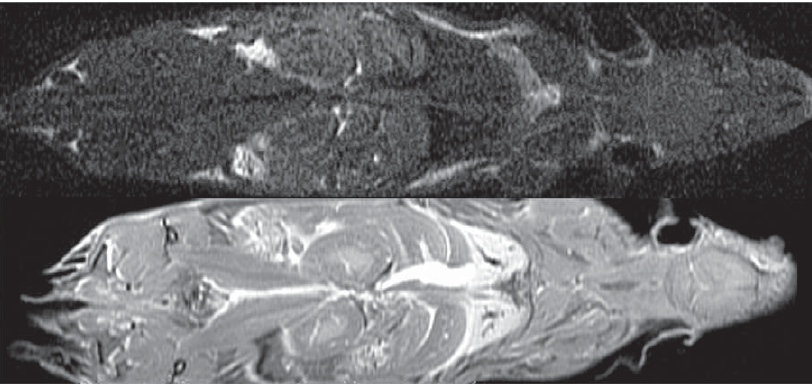
Fig. 4. A five-fold higher signal-to-noise ratio (SNR) per unit scan time can be obtained imaging a specimen prepared with active staining (bottom row: 1:20 Gd-DTPA, 10% formalin) compared to a formalin-fixed specimen (top row: 10% formalin, TR=100ms). SNR increased from 10 to 50. Reprinted with permission from [63].